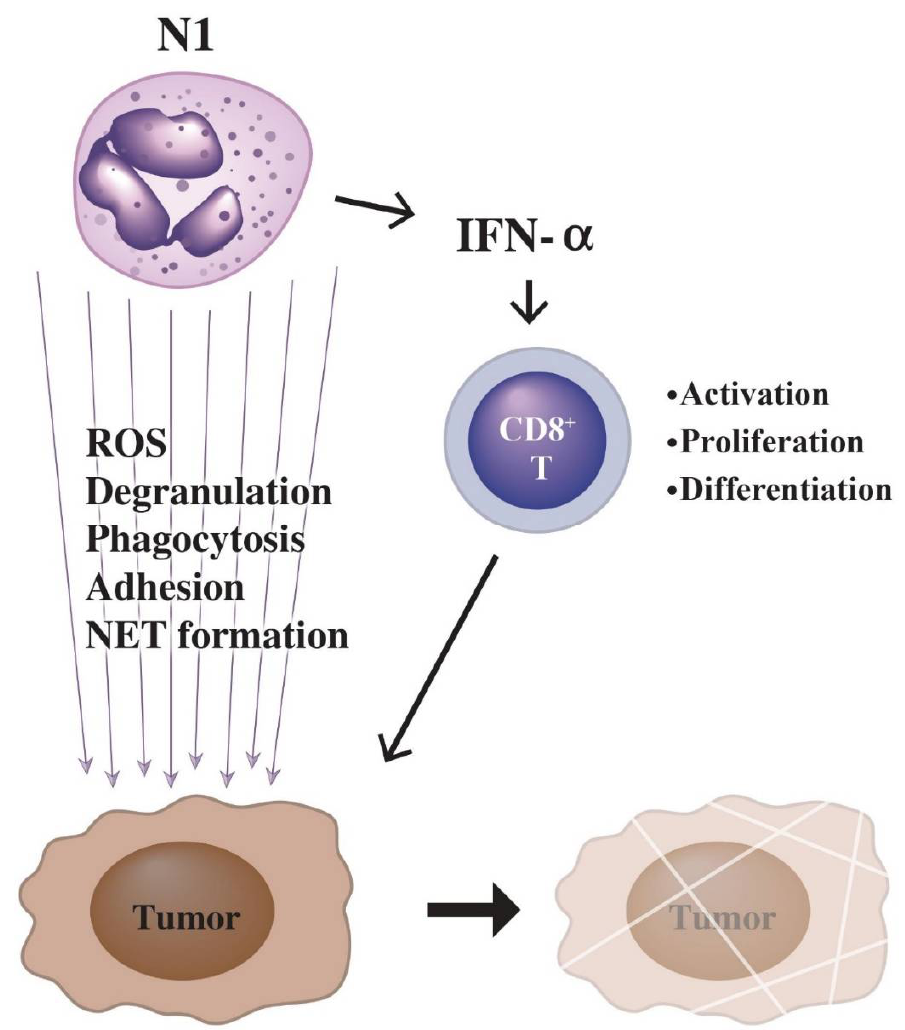
Figure 4. Killing of tumor cells by N1-type PMNs is through two pathways: (1) enhanced tumor- killing activity of cytotoxic CD8 + T-cell by IFN-α released from PMNs; (2) tumor-killing molecules released from PMNs including ROS, granule proteins, and NETs in association with phagocytosis and adhesion of tumor cells by PMNs.